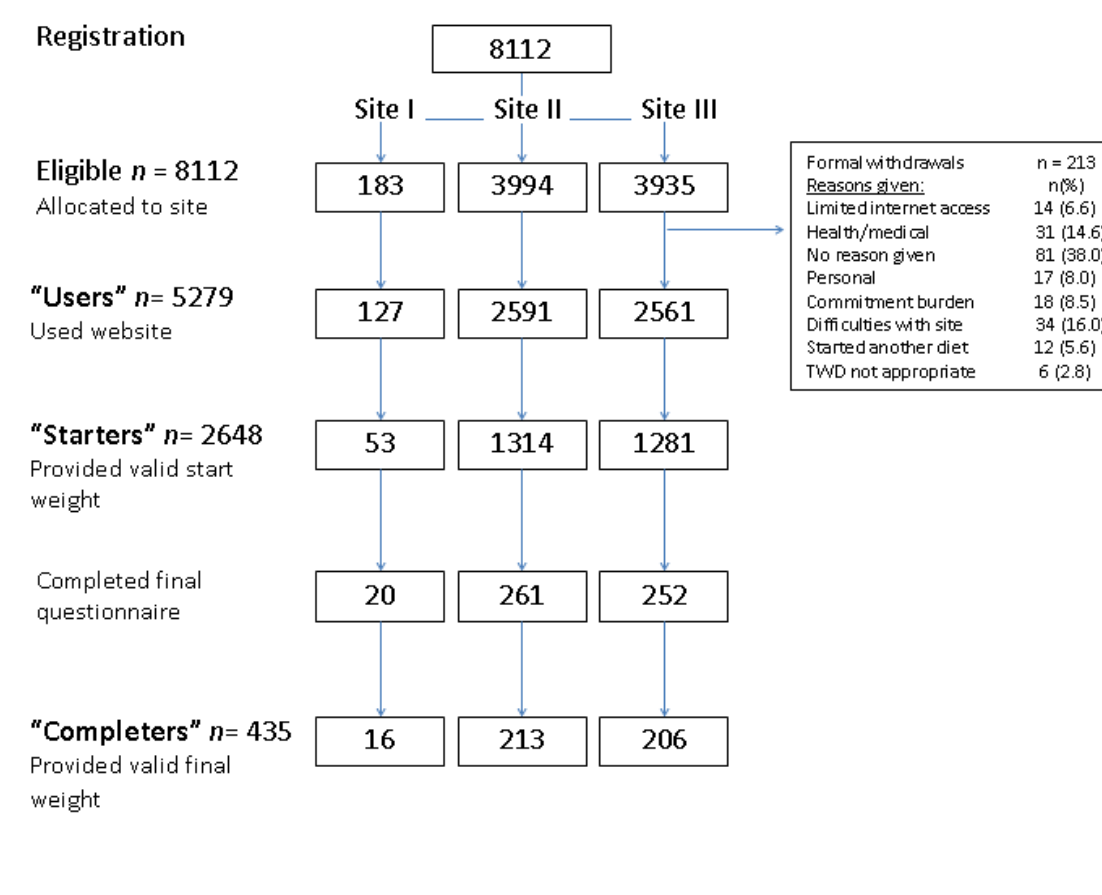
Figure 1. Allocation of participants to websites and numbers remaining at each stage. Site I= Information-based; Site II=Supportive; Site